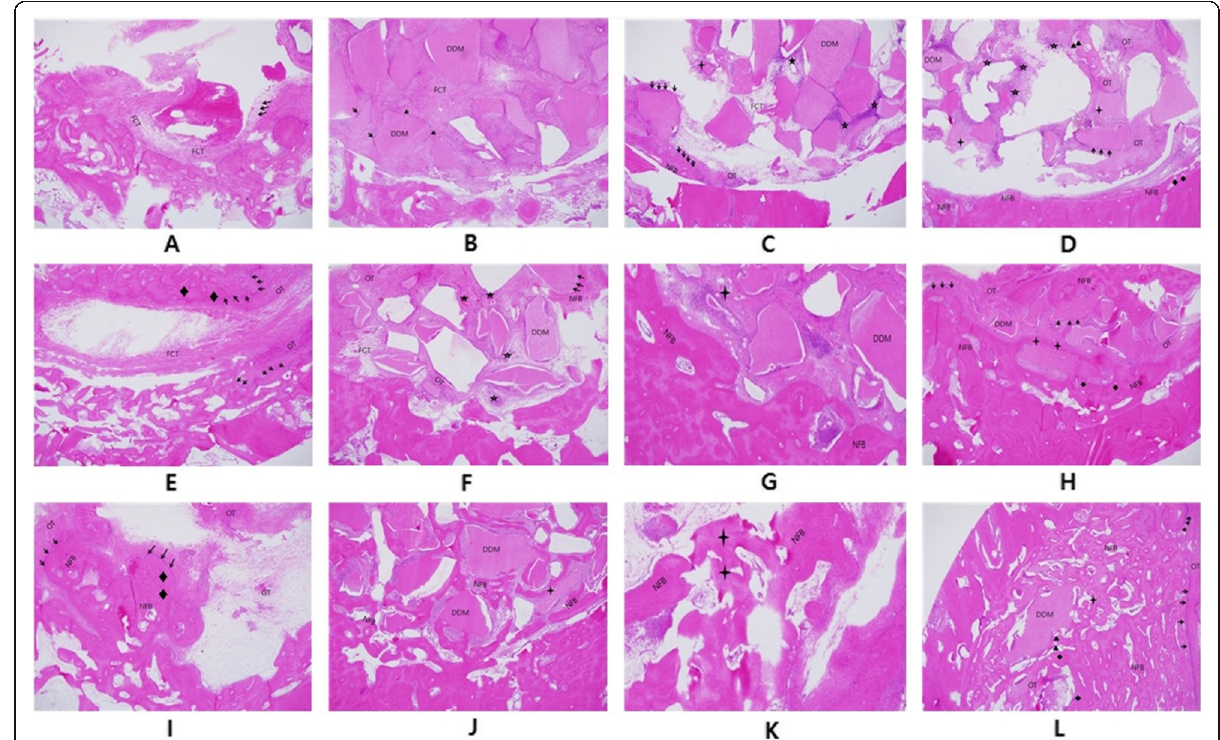
Fig. 2 Hematoxylin and eosin stain (original magnification ×40). A Histologic finding of the control group after 2 weeks (FCT fibrous connective tissue). B Histologic finding of the DDM group after 2 weeks ( → osteoblast, FCT fibrous connective tissue). C Histologic finding of the PRF/DDM group after 2 weeks ( → osteoblast, OT osteoid tissue, ★ blood vessel, FCT fibrous connective tissue, NFB newly formed bone). D Histologic finding of the rhBMP2/DDM group after 2 weeks ( → osteoblast, OT osteoid tissue, ☆ cluster of fibroblast, ◆ osteocyte, : resorbed DDM, ▲ osteoclast, NFB newly formed bone). E Histologic finding of the control group after 4 weeks ( → osteoblast, ◆ osteocyte, OT osteoid tissue, FCT fibrous connective tissue). F Histologic finding of the DDM group after 4 weeks ( → osteoblast, OT osteoid tissue, ★ blood vessel, ☆ cluster of fibroblast, FCT fibrous connective tissue, NFB newly formed bone). G Histologic finding of the PRF/DDM group after 4 weeks (: resorbed DDM, OT osteoid tissue, NFB newly formed bone). H Histologic finding of the rhBMP2/DDM group after 4 weeks ( → osteoblast, OT osteoid tissue, ◆ osteocyte, : resorbed DDM, NFB newly formed bone). I Histologic finding of the control group after 8 weeks ( → osteoblast, ◆ osteocyte, GT granulation tissue, NFB newly formed bone). J Histologic finding of the DDM group after 8 weeks (NFB newly formed bone). K Histologic finding of PRF/DDM group after 8 weeks (: resorbed DDM, NFB newly formed bone). L Histologic finding of the rhBMP2/DDM group after 8 weeks (: resorbed DDM, → osteoblast, OT osteoid tissue, ◆ osteocyte, : resorbed DDM, ▲ osteoclast, NFB newly formed